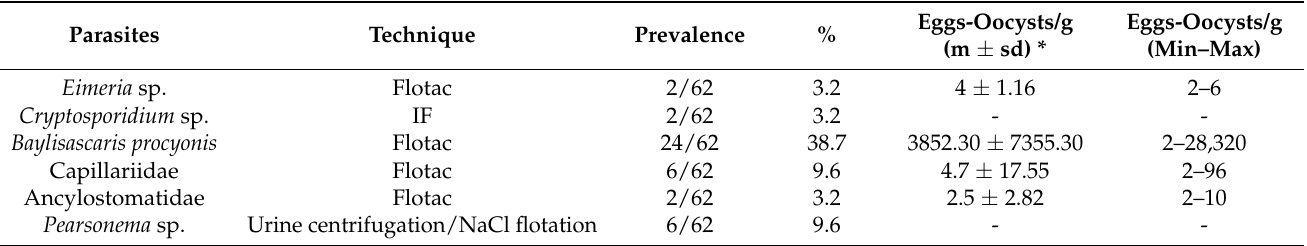
Table 2. Quali-quantitative parasitological results from feces collected from the rectum and from urine sediments of the 62